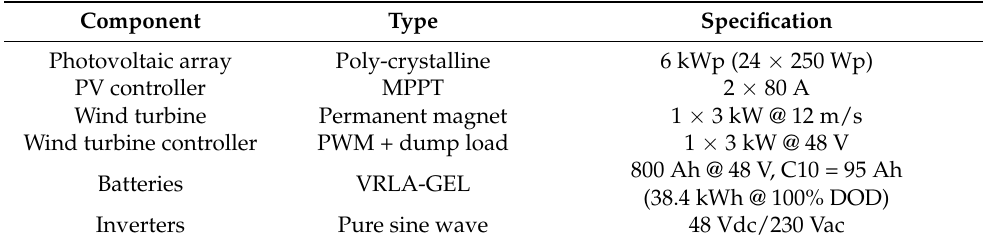
Table 1. Microgrid component specifications.